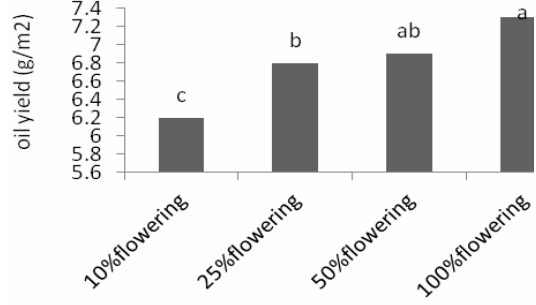
Fig.1. Effect of iron application on plant height